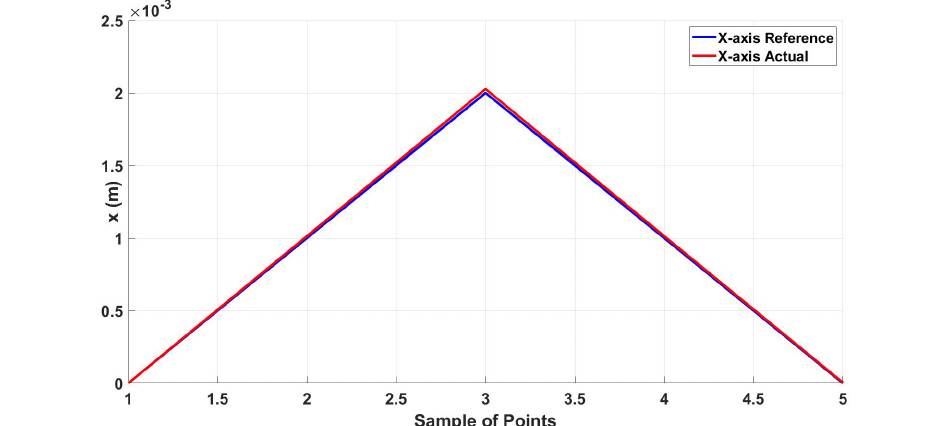
Figure 9. Actual and reference position of the diamond trajectory in the